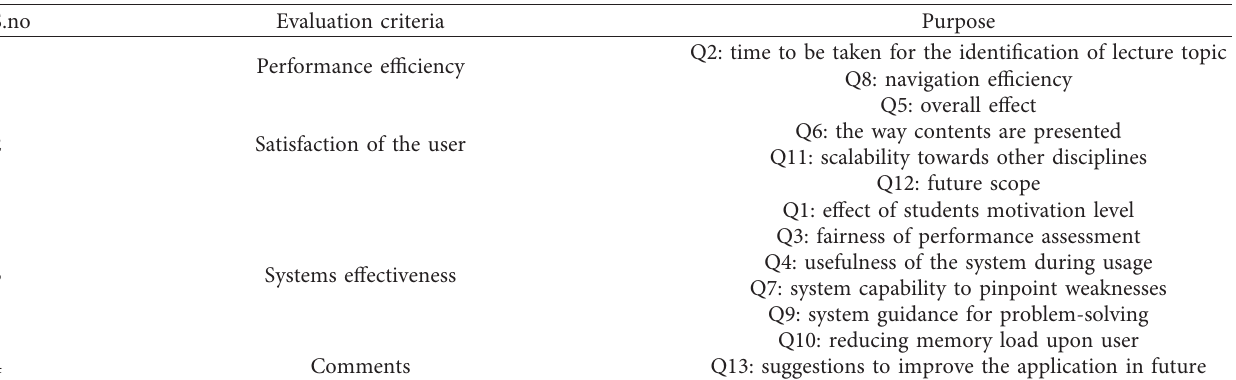
Figure 5: Overview of research design. Table 8: Evaluation